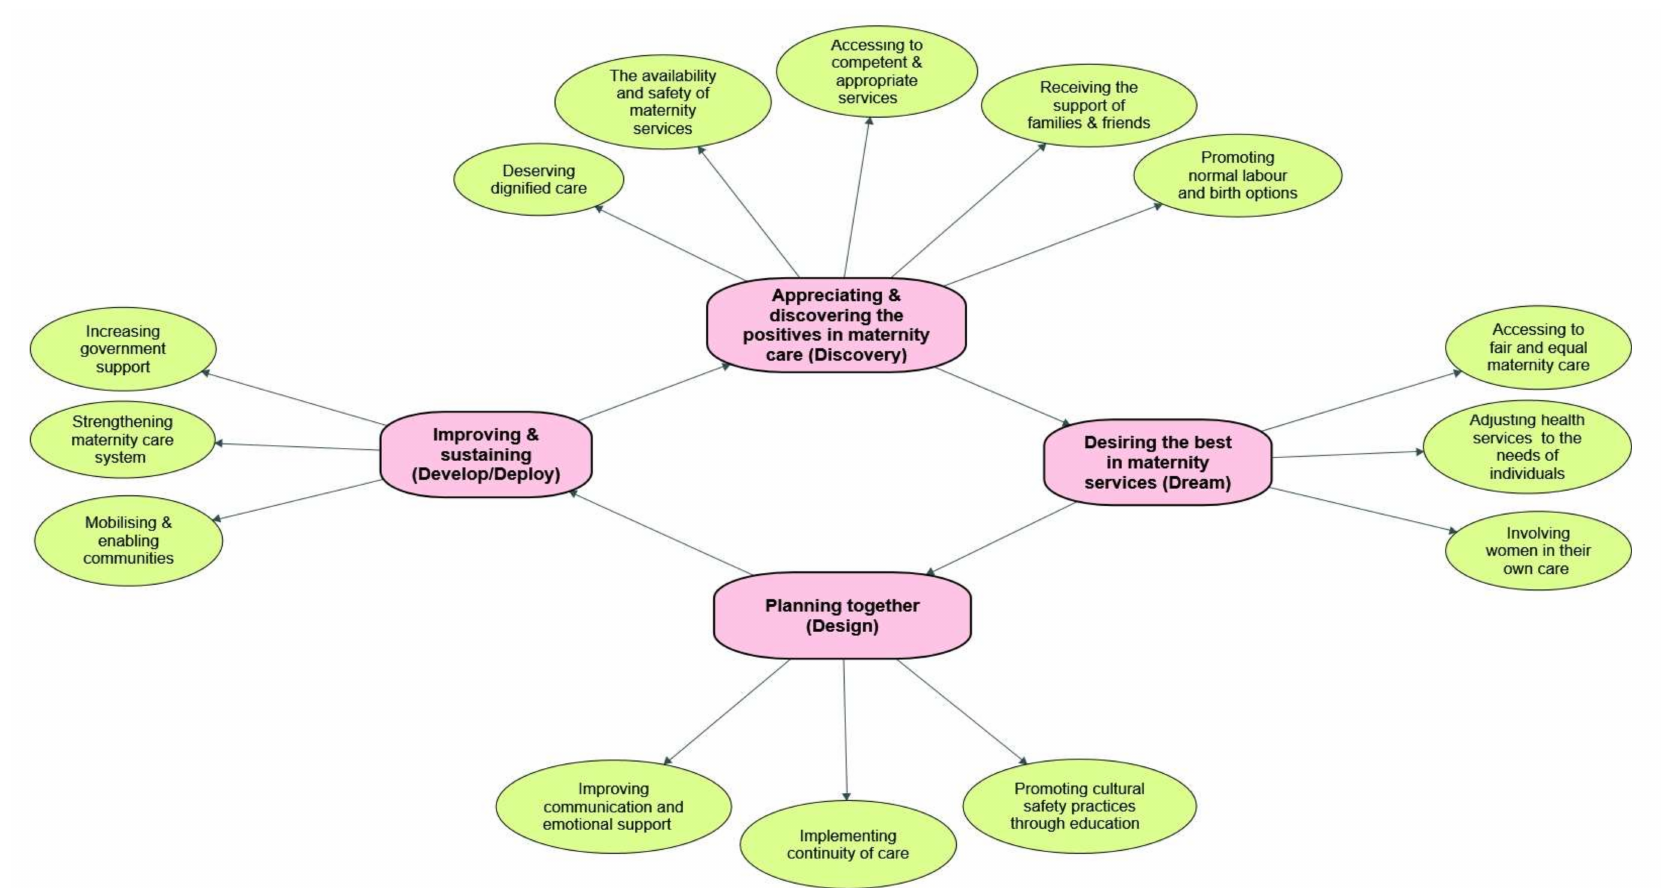
Figure 1. Thematic data analysis based on 4Ds cycle (stages) of Appreciative